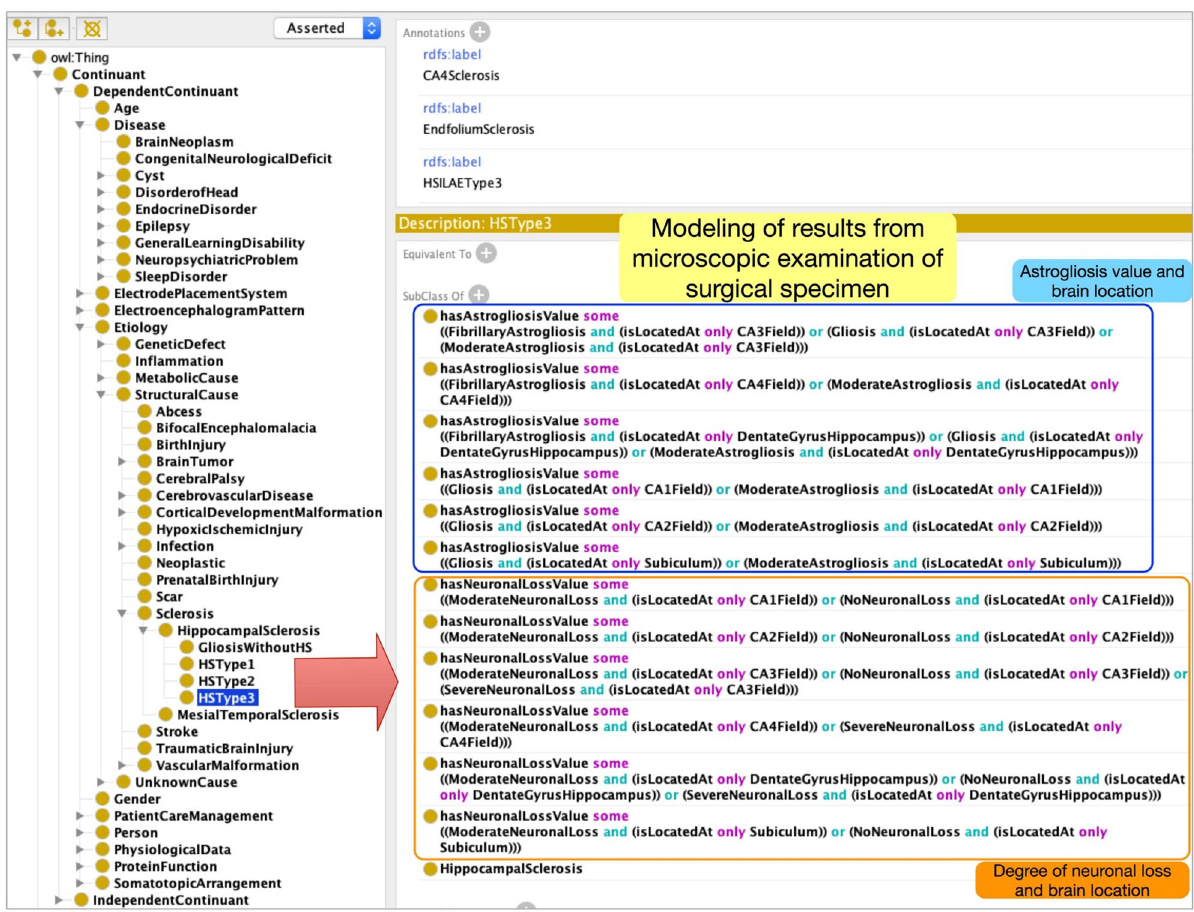
Figure 2. EpSO uses a compositional modeling approach to represent multiple dimensions of neuropathology findings using description logic quantifiers together with OR, AND